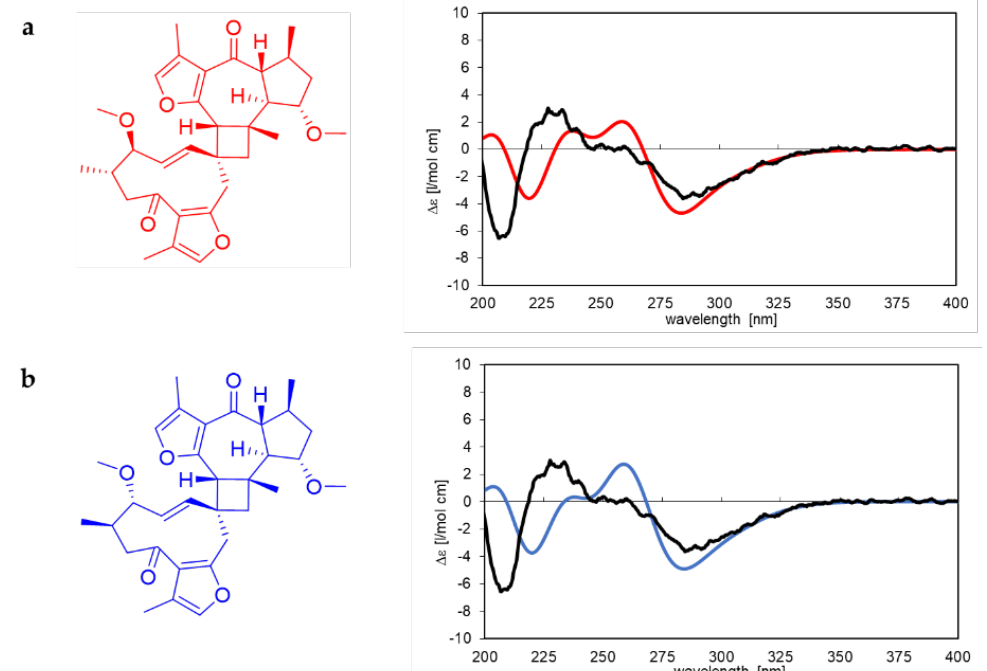
Figure 8. Structures and corresponding simulated ECD spectra of two possible absolute configura- tions of compound 8 are represented in ( a , b ), each shown in the same colour. The experimental ECD spectrum of commiphorine C ( 8 ) is depicted as a black line in both diagrams. The simulation was carried out with TDDFT (B3LYP/6 − 31G(d,p)).